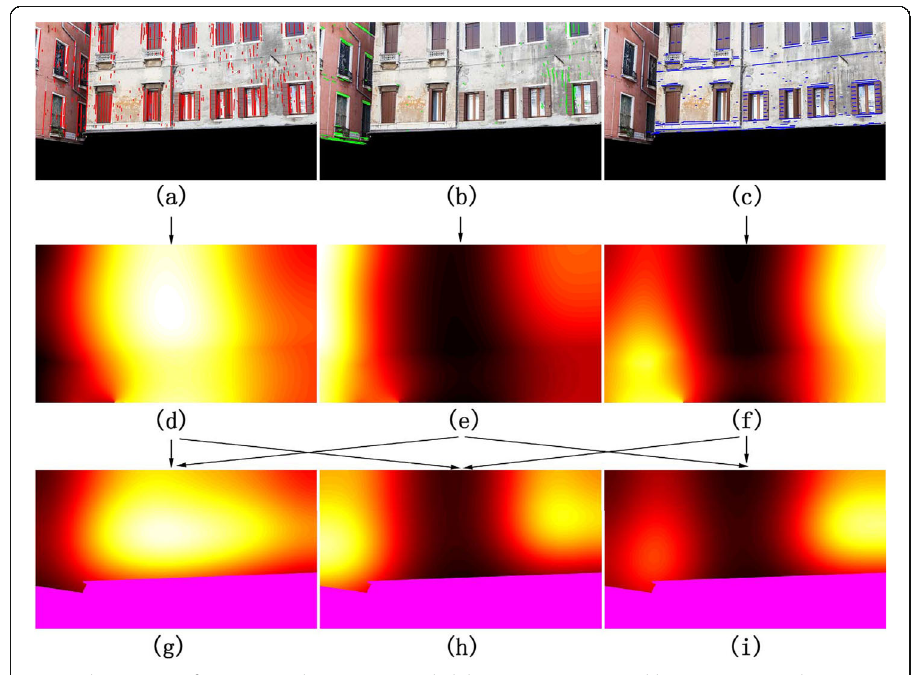
Fig. 2 The process of generating the posterior probability map. a – c Detected line segments in three directions. d – f The density map in three channels. g – i Posterior probability